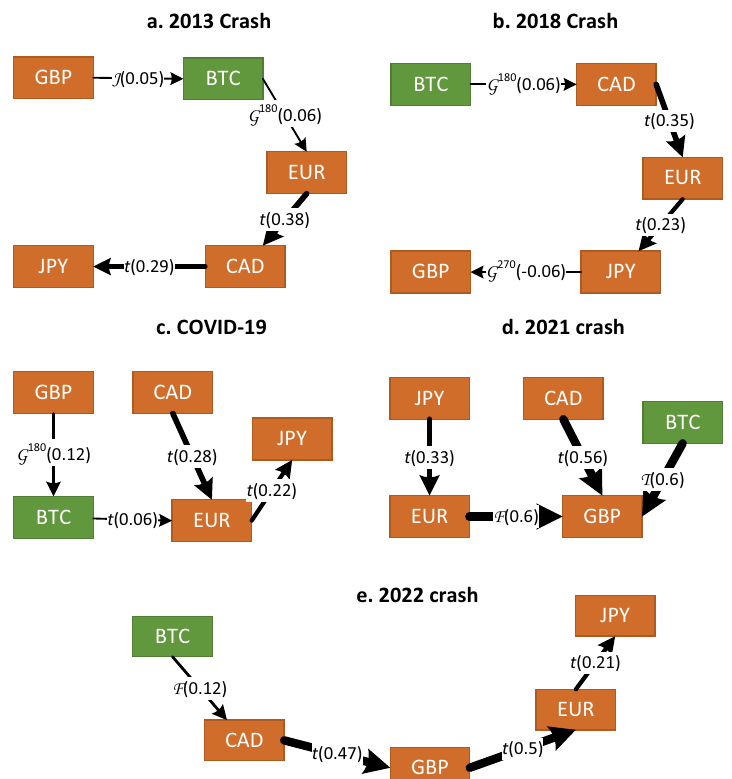
Fig. 6 Estimated R-vine copulas (first trees) for G7 basket during five Bitcoin crashes. The direction of the dependence transmission path is characterized by an arrow that indicates the pair copula and Kendall’s τ in parentheses. The strength of the dependence is illustrated with the thickness of the